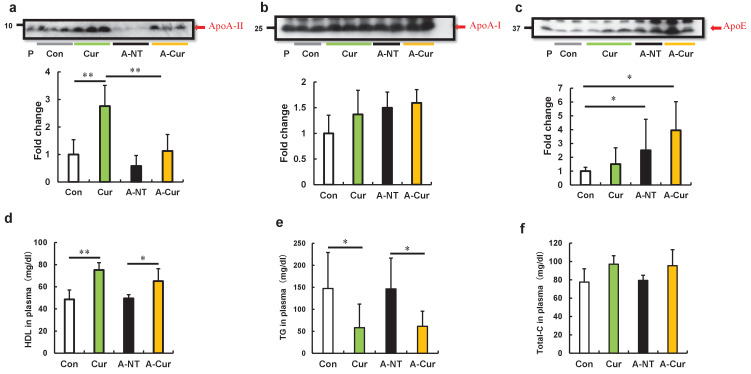
Curcumin elevated ApoA-II levels and affected lipid metabolism in mice after 12 weeks.(a–c) Plasma concentrations of ApoA-II, ApoA-I, and ApoE were determined by densitometry of Western immunoblot after SDS-PAGE. Representative results of western blot are shown above the figures. Histograms show fold changes relative to the Con group and represent the means ± SD. P indicates the pooled plasma of female R1.P1-Apoa2c mice at 2 months of age (N = 4) that did not have AApoAII amyloid deposits, as the positive control. (d–f) Plasma concentrations of HDL cholesterol, triglycerides (TG), and total cholesterol (Total-C) were determined using quantitative assay kits. N = 3–5. The Tukey–Kramer method was used for multiple comparisons; *p < 0.05. **p < 0.05.